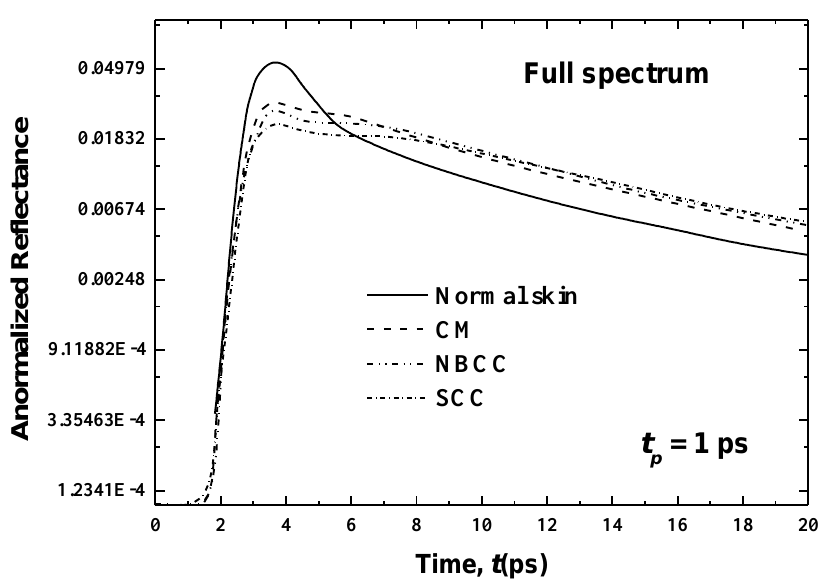
Figure 7. Temporal signals of normalized reflectance from the normal skin and skin with malignancy that has spread to the living epidermis.